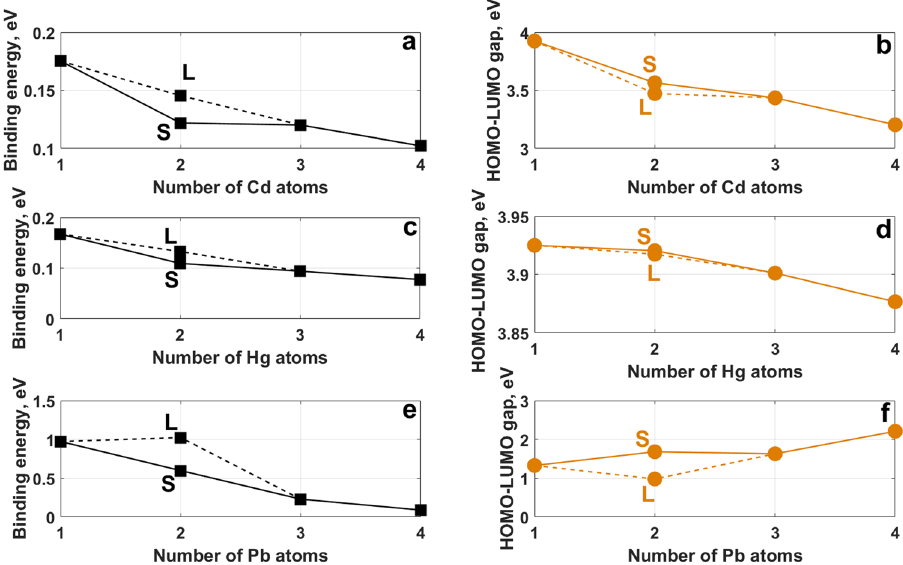
Figure 9. Dependences of the binding energy and HOMO-LUMO gap on the number of heavy metals’ atoms on the C 16 H 10 GQDs: Cd ( a,b ), Hg ( c,d ), and Pb ( e,f ), respectively. L and S denote the longer and shorter initial distances between adsorbed adatoms on graphene